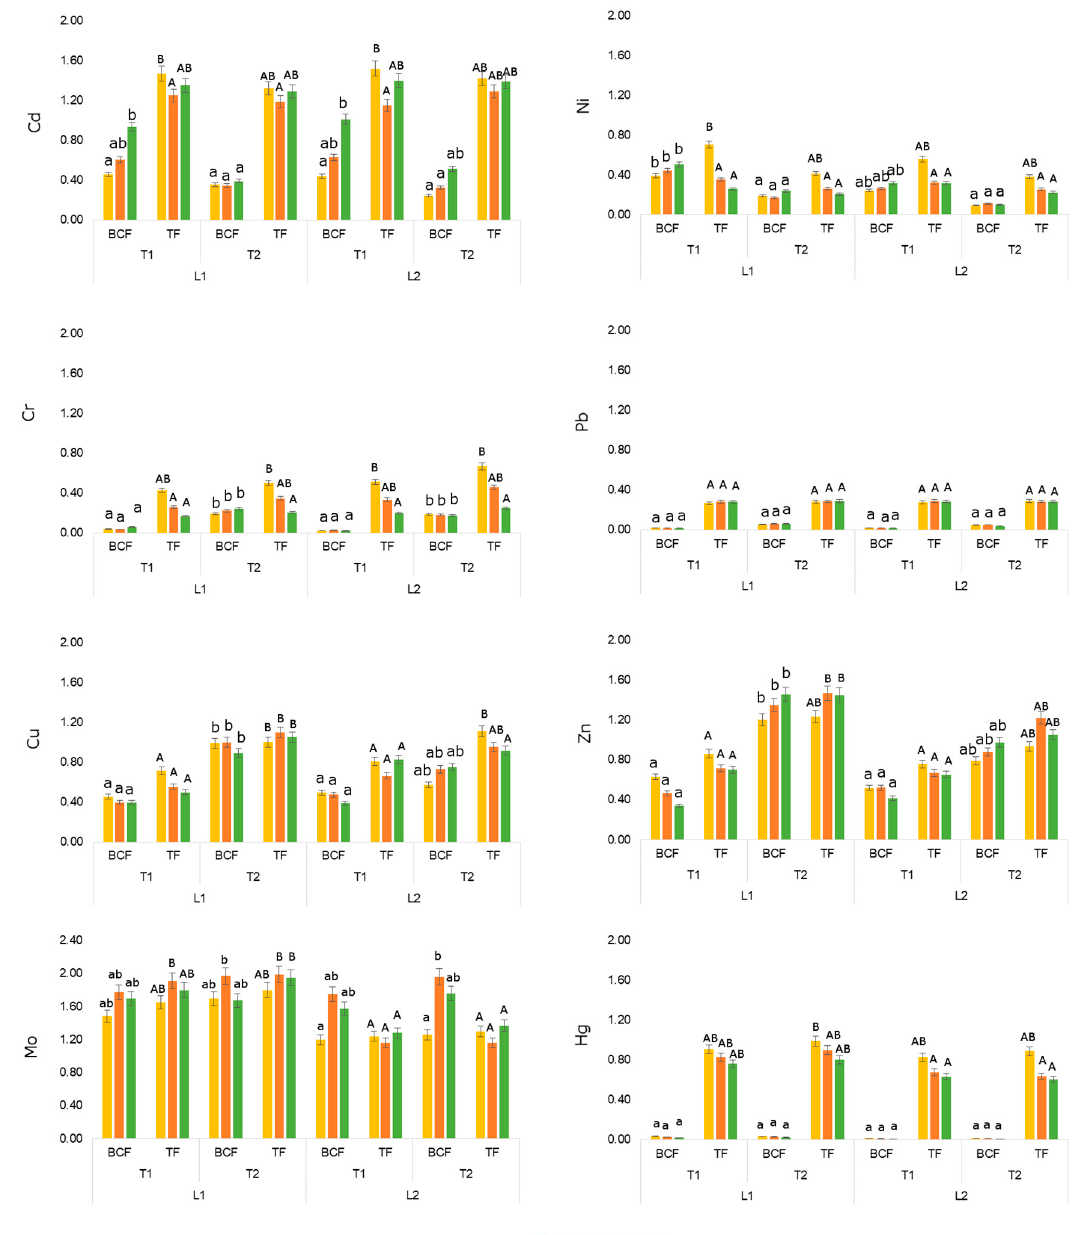
Figure 6. Bioconcentration (BCF) and translocation (TF) factors calculated for Cd, Cr, Cu, Mo, Ni, Pb, Zn, and Hg for soil and grass mixture samples from the control plots (C) and plots fertilized with sewage sludge in a dose of 14.5 t DM/ha (G1) and 29 t DM/ha (G2) in L1 and L2, collected in first (T1) and second (T2) year of study. Different letters (small letters—shoot, capital letter—root) above bars (mean ± SD) represented significant differences assessed with the Tukey test at p < 0.05.